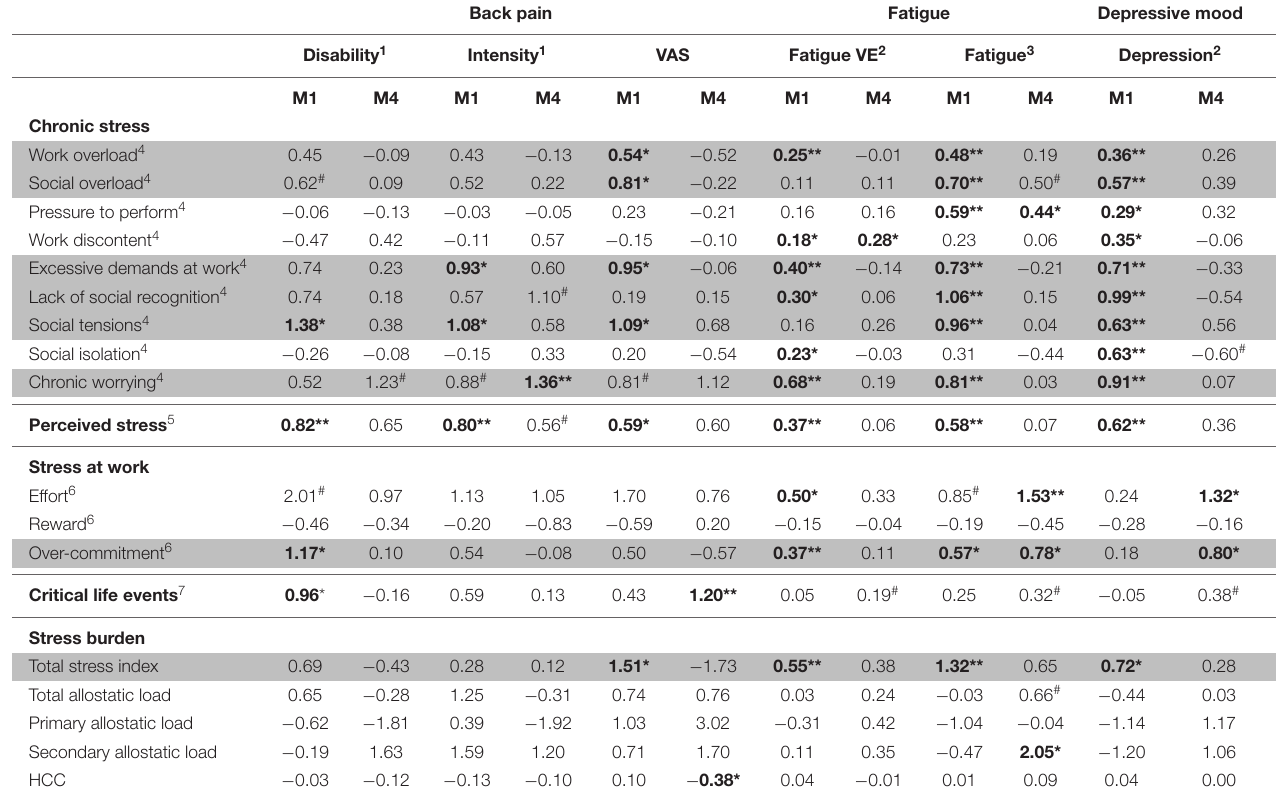
TABLE 1 | Main effects: (regression coefficients ß) for the influence of types and burden of stress (psychometric and physiological measures) on the outcome criteria back pain, mood, and fatigue as well as symptom triad (gray marked). Back pain Fatigue Depressive